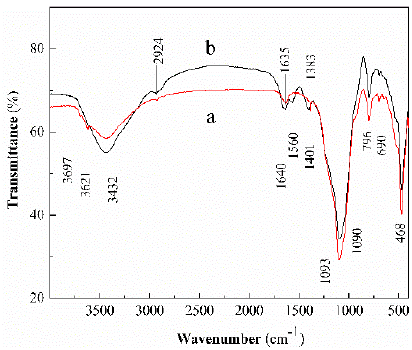
Figure 1. The FTIR spectra of ( a ) raw diatomite and ( b ) chitosan (CS)-modified diatomite (Dt).